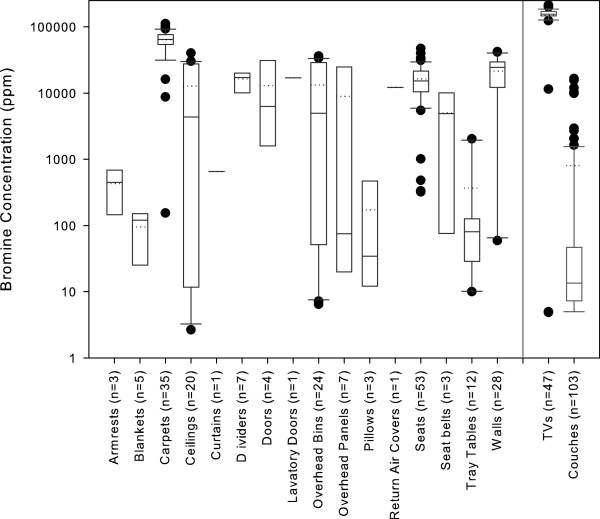
Distribution of bromine concentrations in airplane materials in this study compared to TVs and couches[[11]].